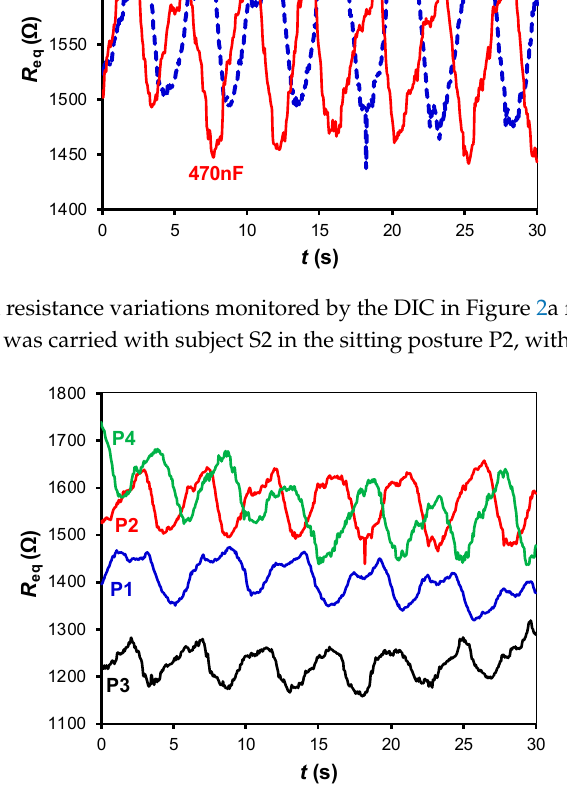
Figure 9. Small-signal resistance variations monitored by the DIC in Figure 2a for different sitting postures (see Figure 5). The test was carried with subject S2 at f s = 20 Sa/s and with C = 1 µF.